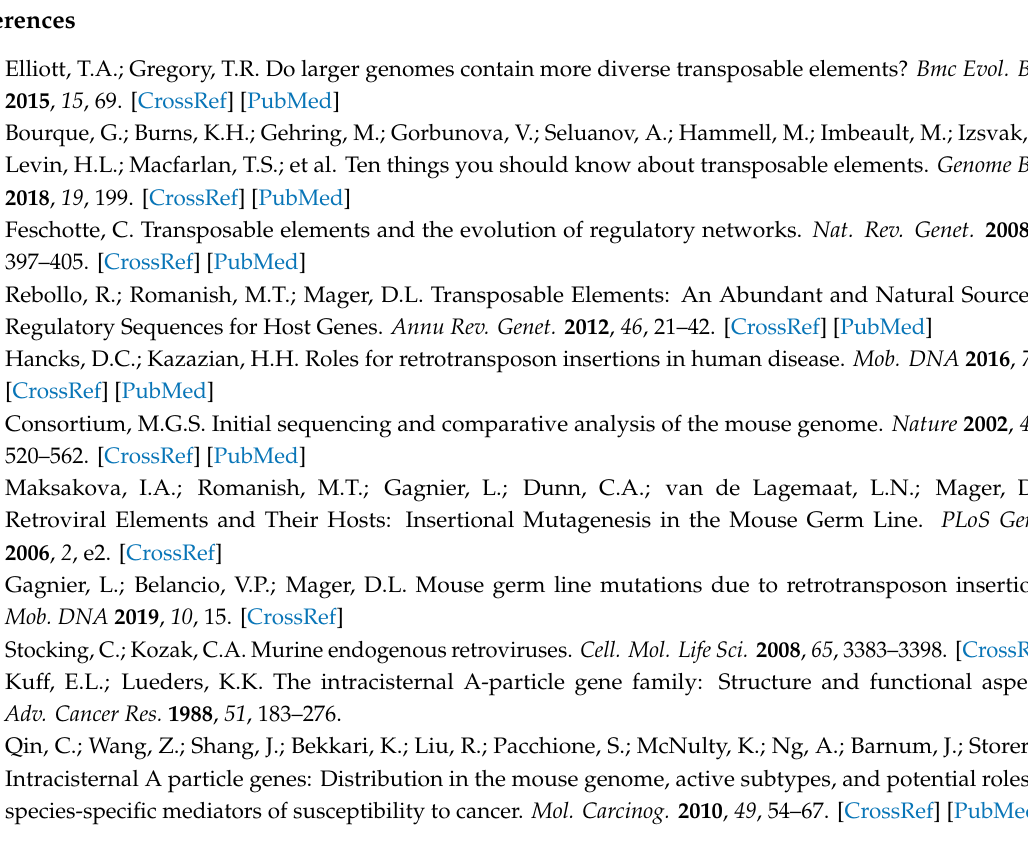
Figure S1: H3K4me3 enrichment in TSSs for all datasets studied. Figure S2: Supporting data for Figure 1. Figure S3: ChIP-qPCR of H3K9me3 and H3K4me3 for IAP copies. Figure S4: Permissive IAP C3H / HeJ copies H3K4me3 and H3K9me3 average profile. Figure S5: H3K4me3 enrichment in empty sites of Bruce4 and E14. Figure S6: H3K4me3 enrichment in flanking regions of common copies of C3H / HeJ, 129 and C57BL / 6 of Bruce4 and E14. Supplementary Data 1: DNA and protein sequences of the full length “master” IAP copy, along with alignments between IAP #60 and the orthologous copy in 129. Table S1: Primer sequences. Table S2: H3K4me3 IAP copies in C3H / HeJ ES